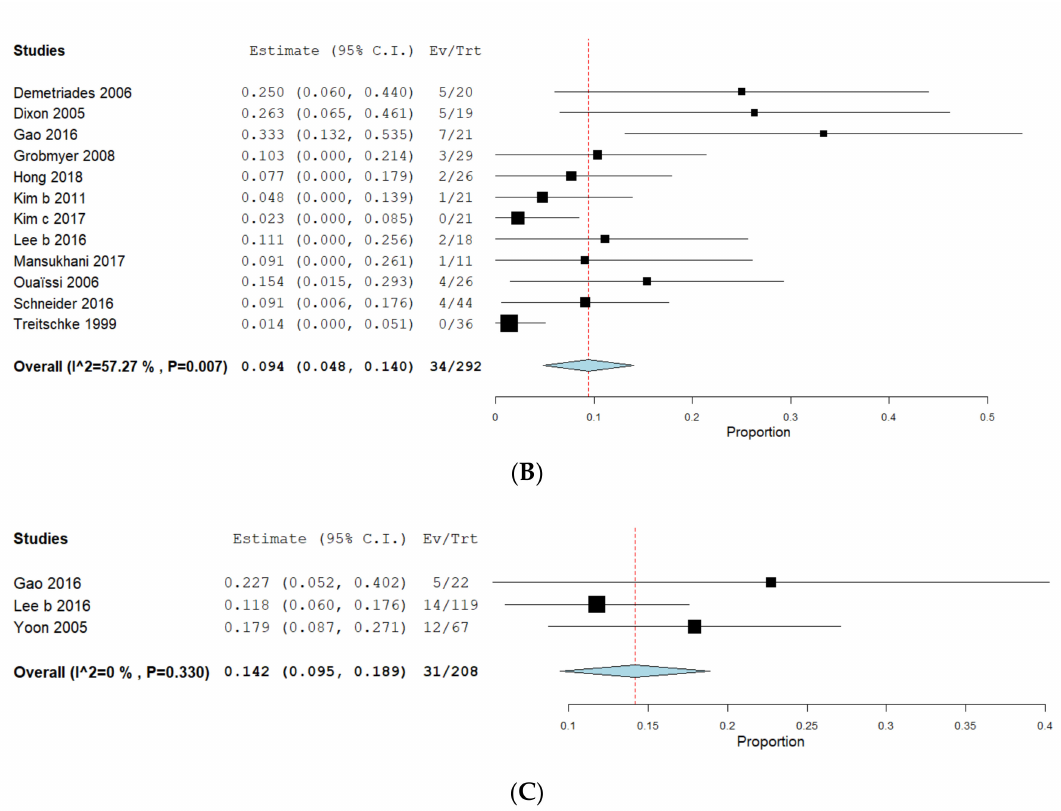
Figure 4. Recurrence in endoscopic and surgical intervention. Proportions of meta-analyses were calculated and shown as forrest-plots for EA ( A ), SA ( B ) and PD ( C ). Pooled rates of recurrence were calculated to obtain a proportion with a 95% confidence interval (CI). The binary random e ff ects model (DerSimonian–Laird) was used for EA and SA and a fixed e ff ect model with inverse variance weighting was used for PD. EA: endoscopic ampullectomy, SA: surgical ampullectomy, PD: